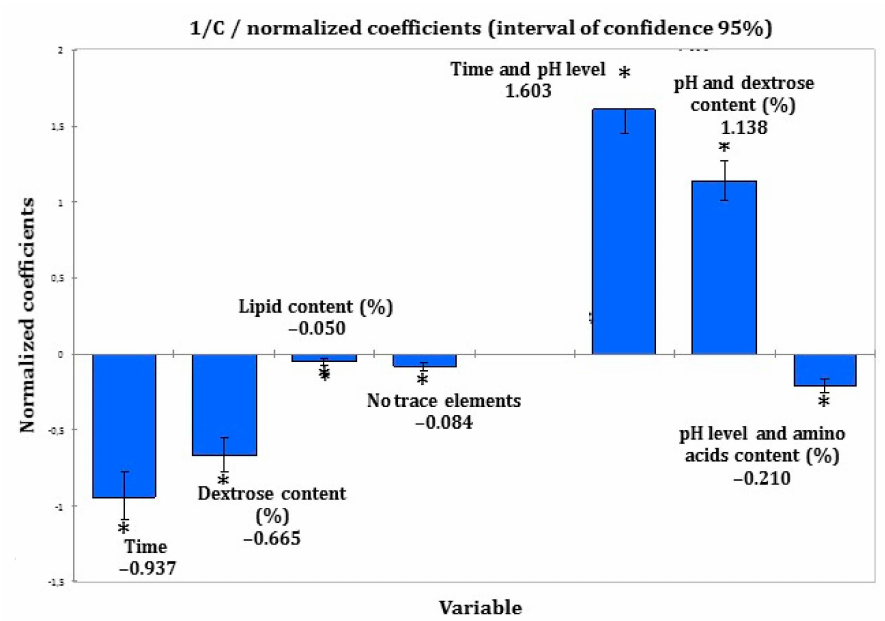
Figure 6. ANCOVA normalised coefficients (CI 95%); *: p <